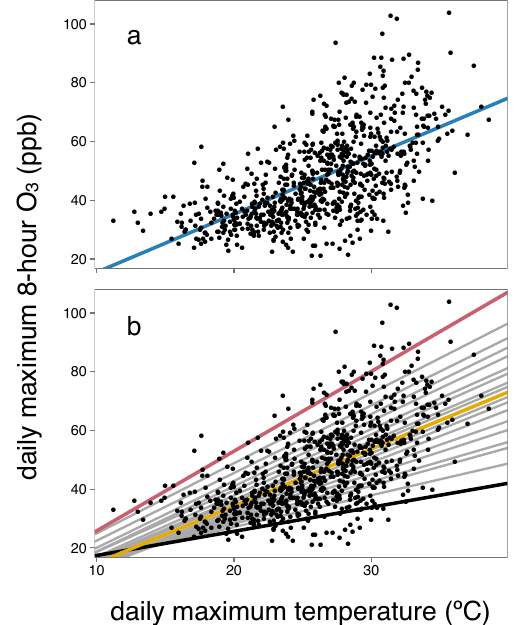
Figure 1. Daily maximum 8h O 3 vs. maximum daily temperature for an example site in Essex County, MA (JJA, 2004–2012). An or- dinary least-squares regression line (a) captures the general trend, but is unable to represent the increase of variability in the distri- bution with increasing temperature. Using individual quantile re- gressions ranging from 5th to 95th percentiles (b) , the increased sensitivity of higher quantiles to increased temperatures becomes